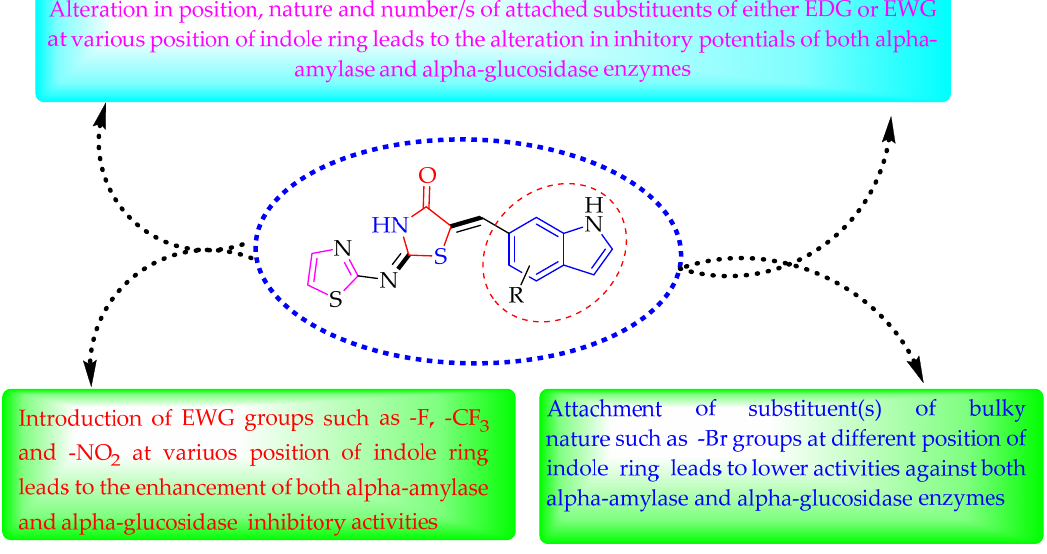
Figure 2. Summary of SAR studies for α -amylase and α -glucosidase inhibitory